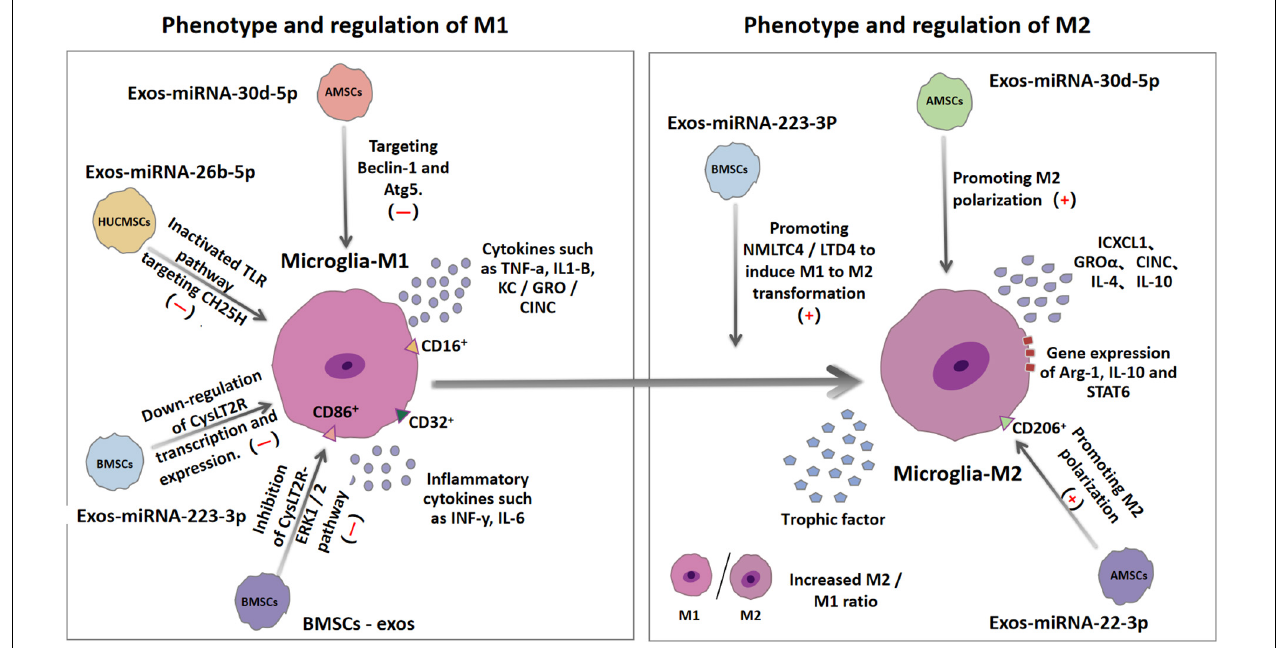
FIGURE 2 | Ischemia and hypoxia can lead to the polarization of microglia into M1 microglia and M2 microglia. The surface antigens of the two microglias are different. M1 microglia expresses CD16, CD32, and CD86, while M2 microglia expresses CD206. MiRNA in exosomes derived from different types of mesenchymal stem cells can regulate some inflammatory pathways or mechanisms to up-regulate or down-regulate the production of M1 and M2, thereby changing the ratio of M1/M2 in the brain and reducing the inflammatory response and secondary tissue damage involved in